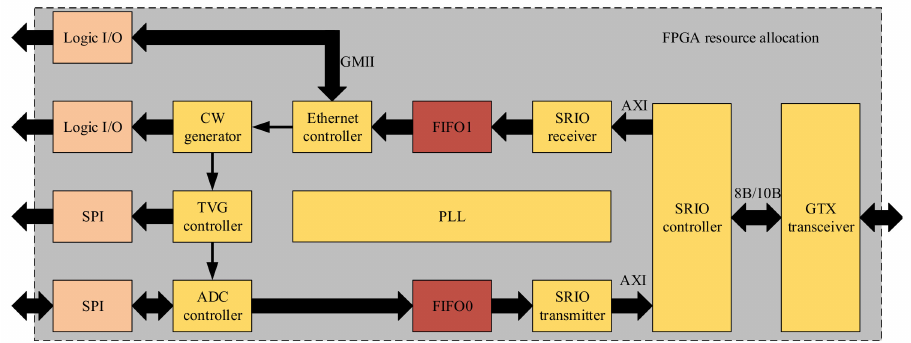
Figure 15. The resource allocation used in the